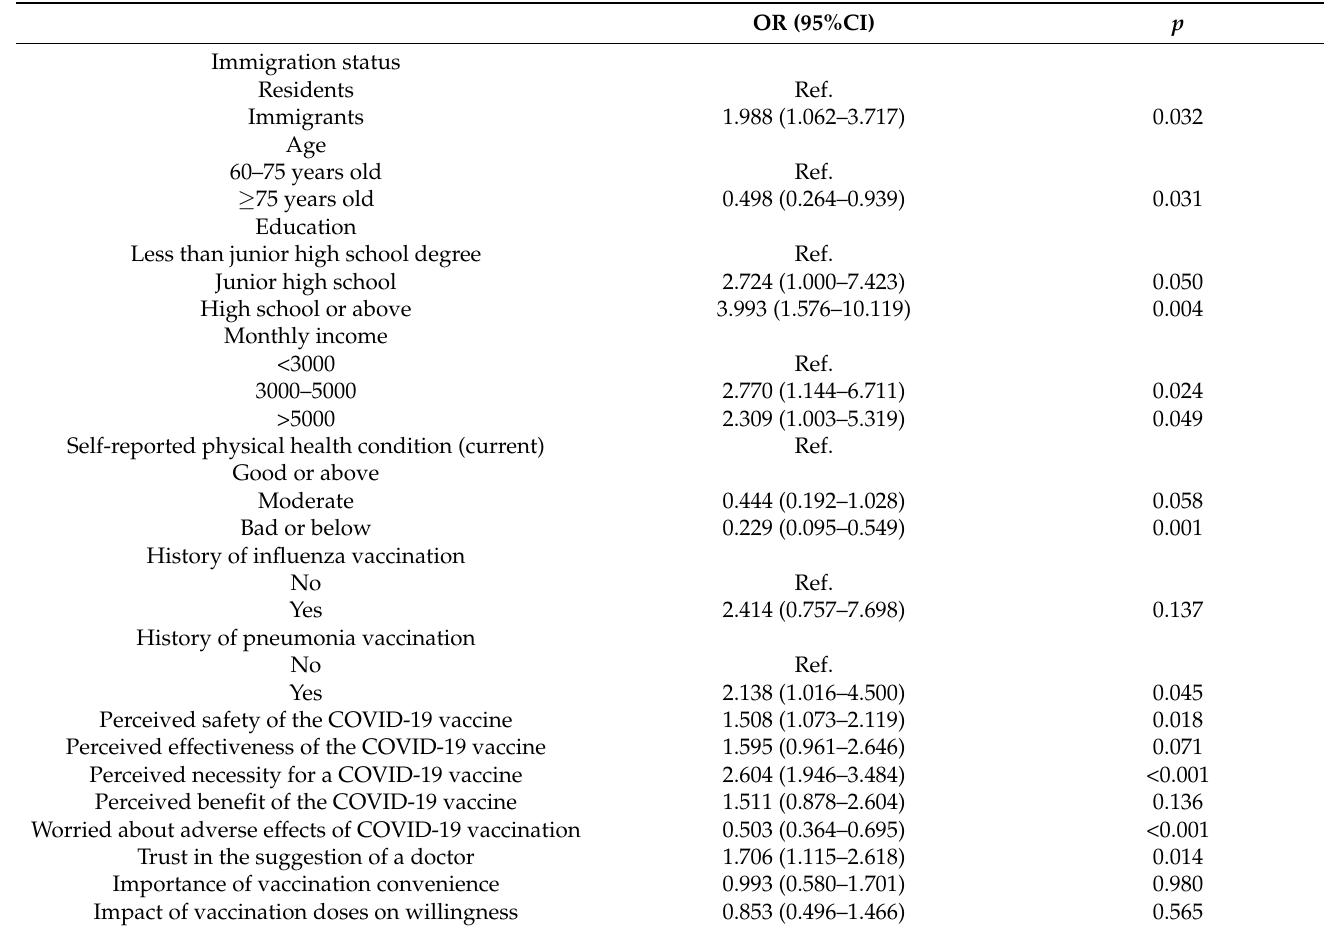
Table 4. COVID-19 vaccination acceptance of older people by multivariate logistic regression